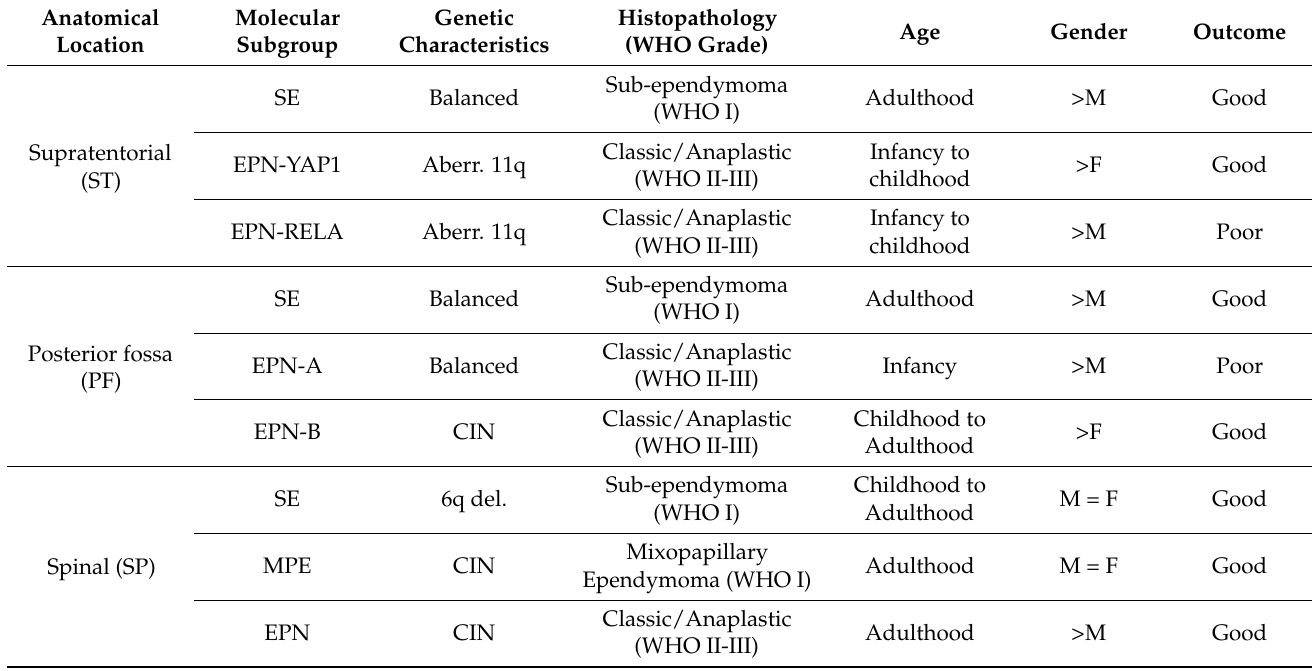
Table 1. Clinical and molecular characteristics of ependymomas based on tumor